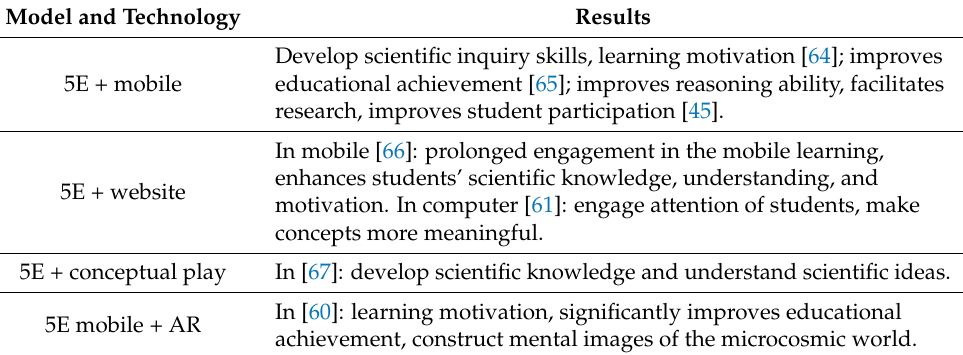
Table 1. 5E model and